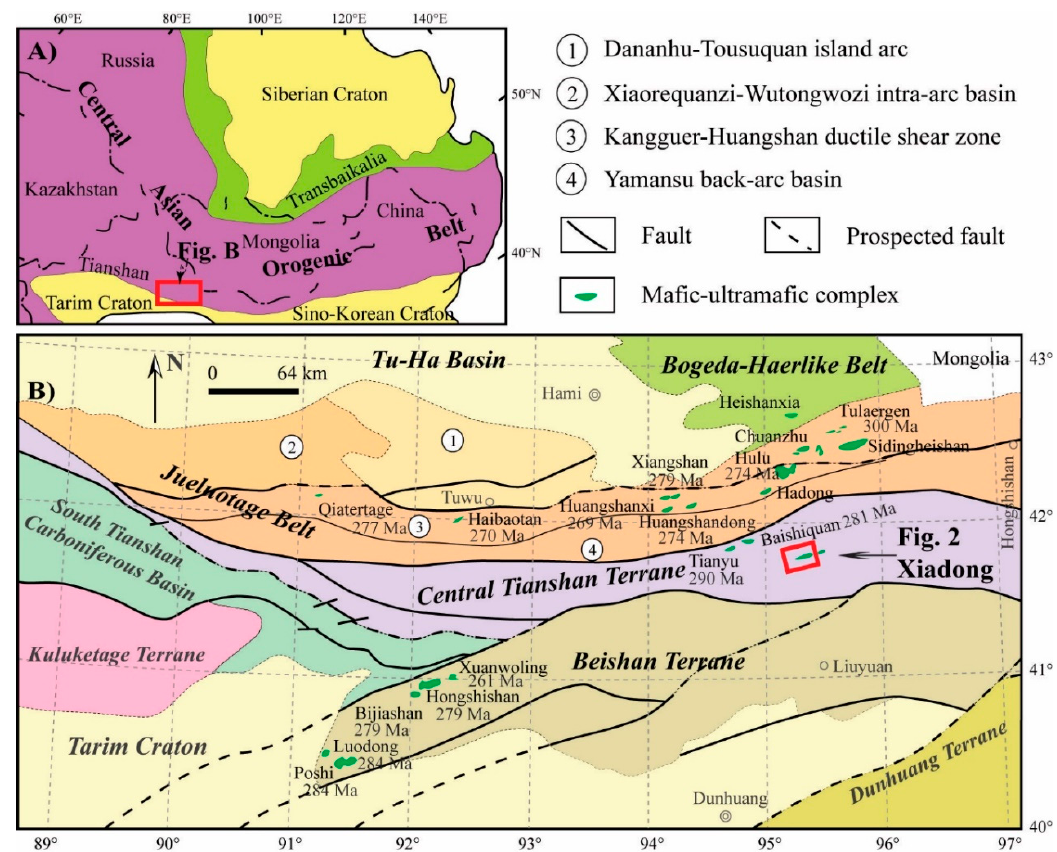
Figure 1. ( A ) Location map of the study area in the Central Asian Orogenic Belt. ( B ) Geological map of the Eastern Tianshan and Beishan orogens showing the distribution of Paleozoic mafic–ultramafic complexes (modified from References [15,17]). The reported numbers represent the ages of known intrusions.